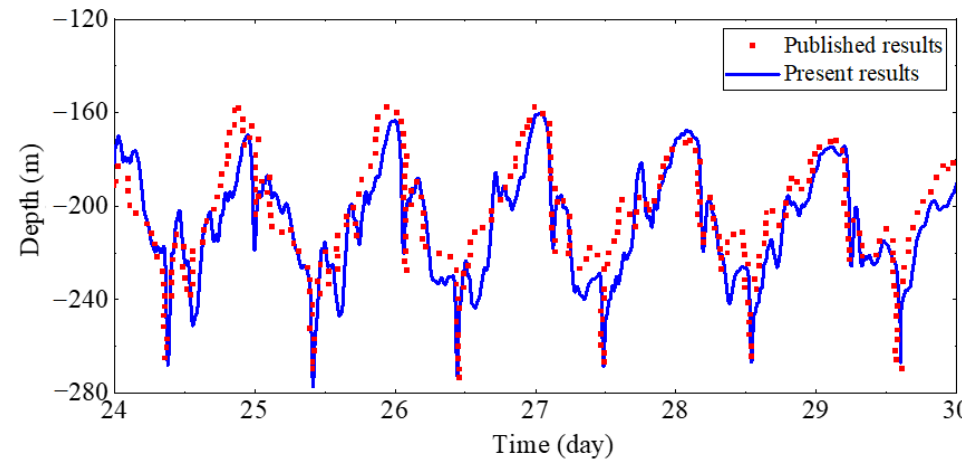
Figure 4. Isotherm and its filtering results for the simulation of point S7.